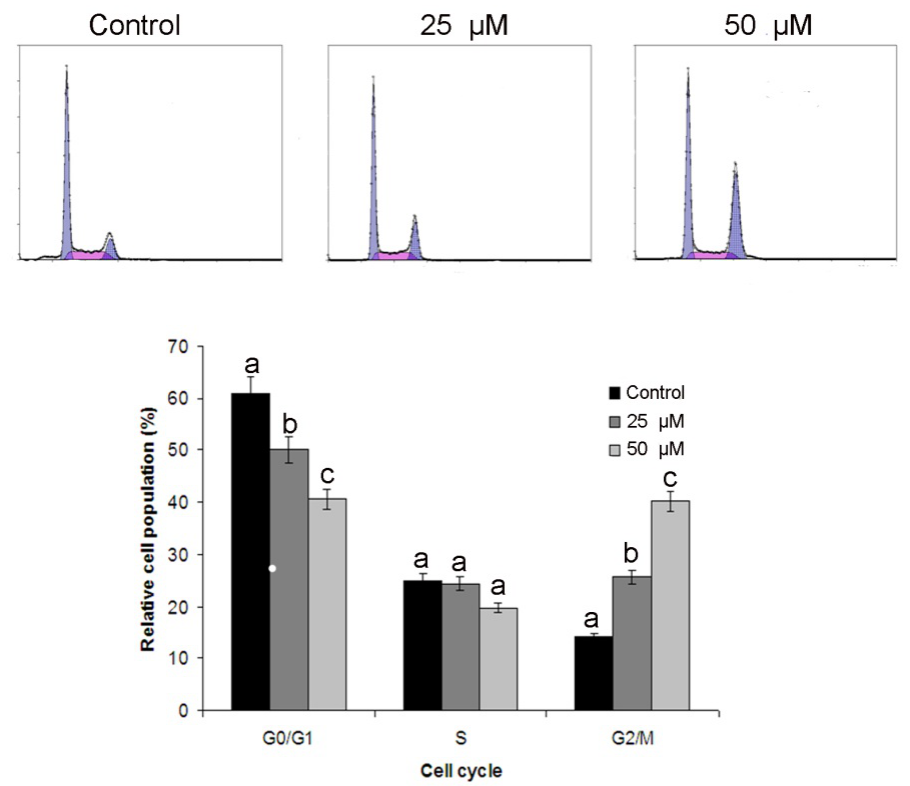
Figure 5. Flow cytometry analysis of cell cycle phase distribution in T24 cells treated with 25 and 50 µM costunolide for 24 h. Data are expressed as Mean ± SD (n = 3). Columns not sharing the same superscript letter differ significantly ( p <